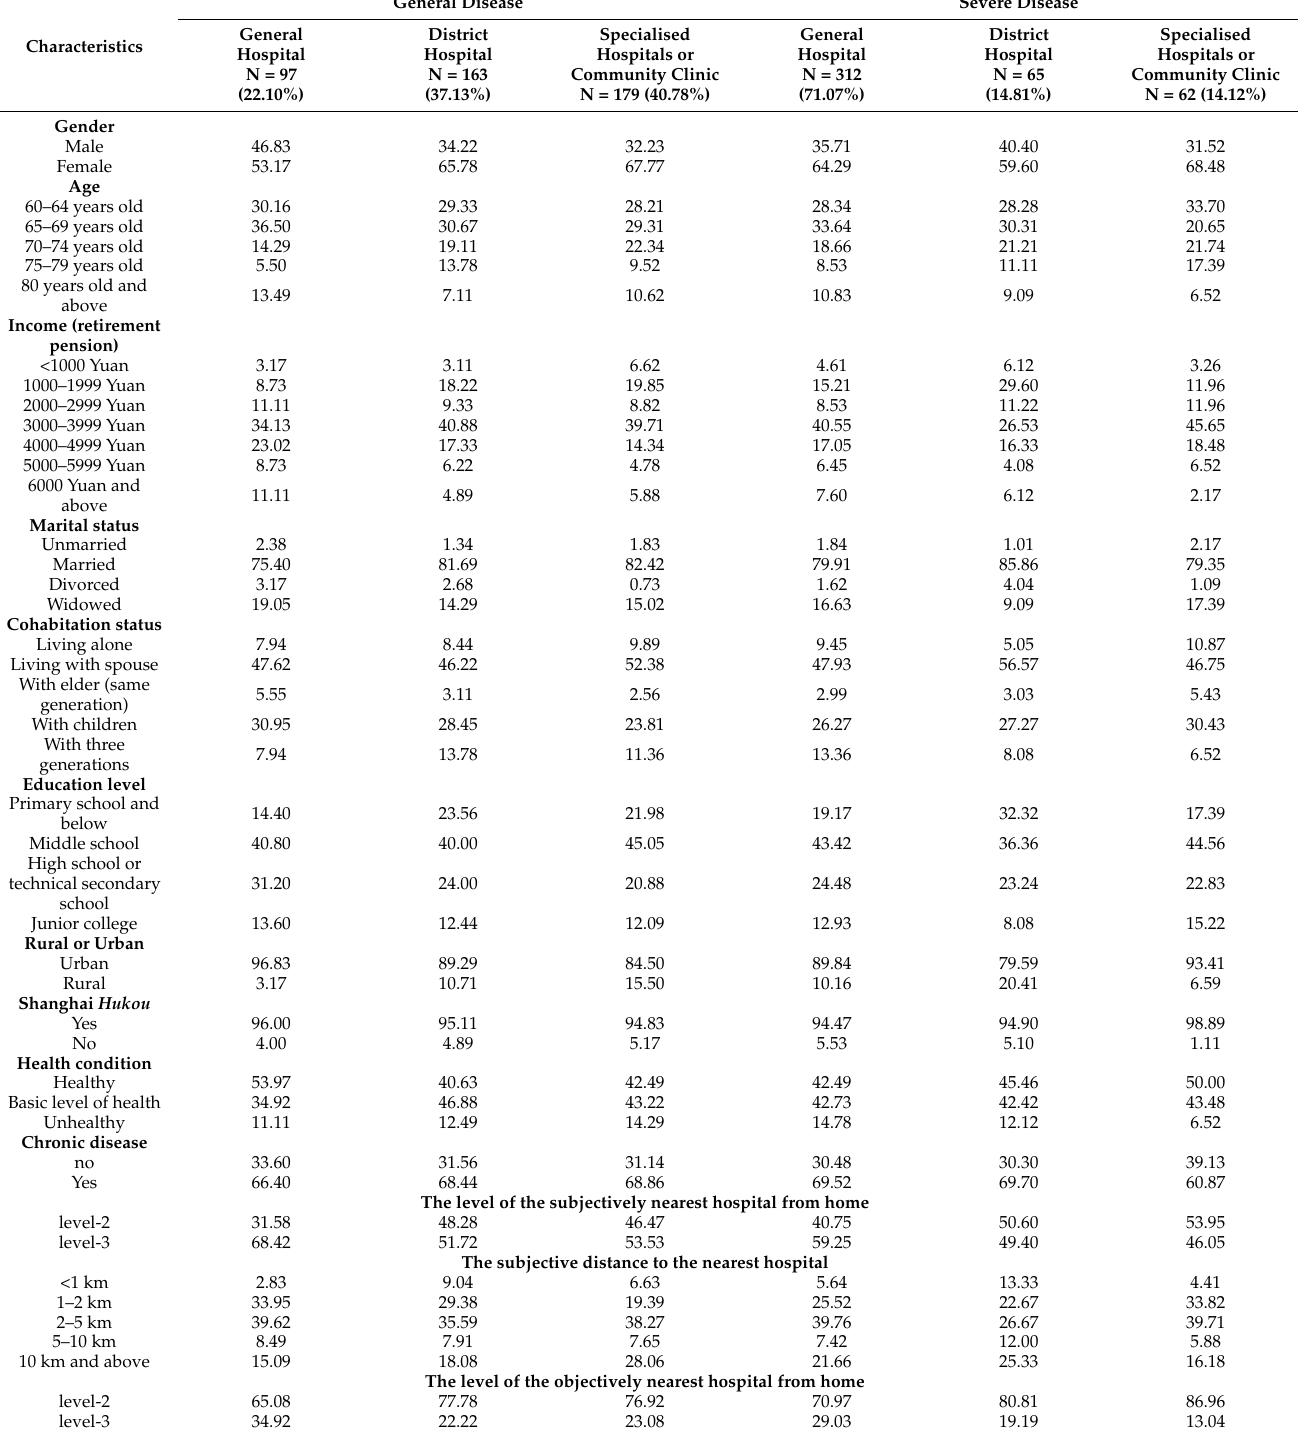
Table A1. The elderly population’s options taken with general disease and severe disease